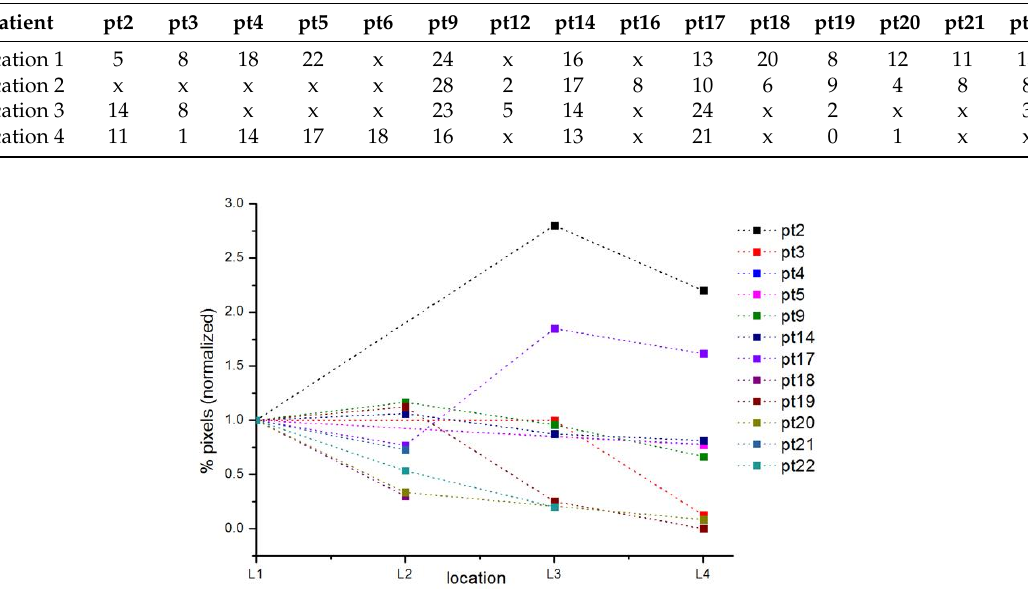
Table 1. Percentage of pixels indicative of flow per patient per location obtained from the OCT M-mode scans. In red the flow in location 4 of the gastric tube.